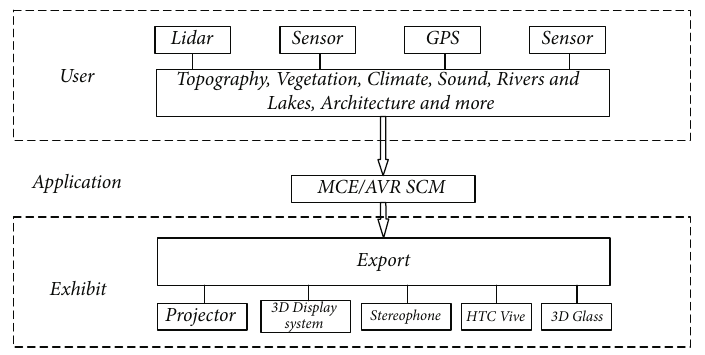
Figure 4: Framework of landscape virtual reality